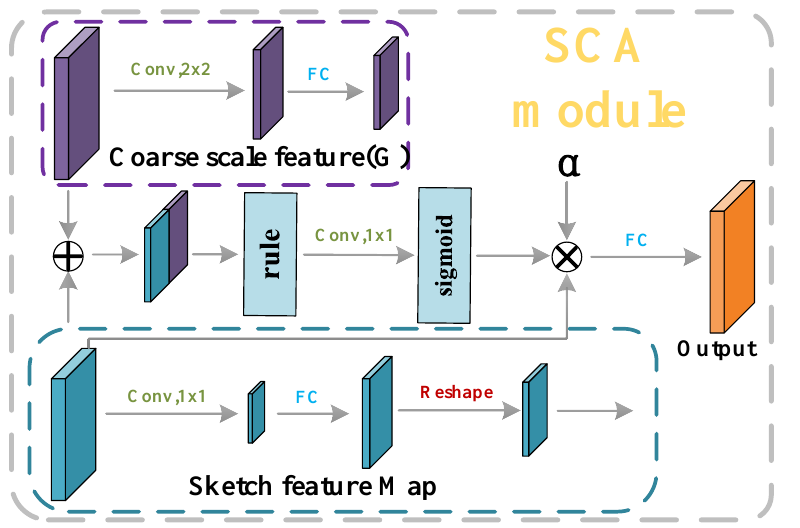
Figure 4. The proposed skip connection attention (SCA) integrates skip connection and attention mechanisms to discriminate semantic information consisting of dense lines